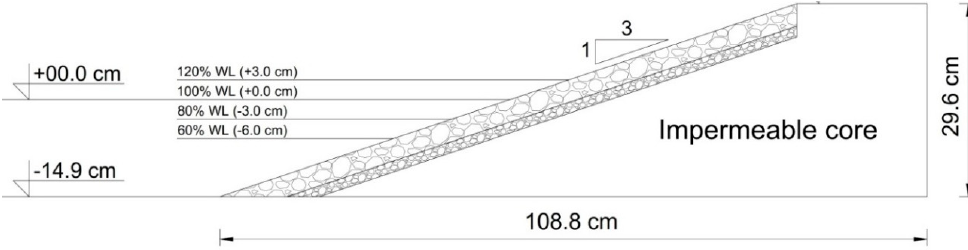
Figure 2. Structure geometry with a straight slope.